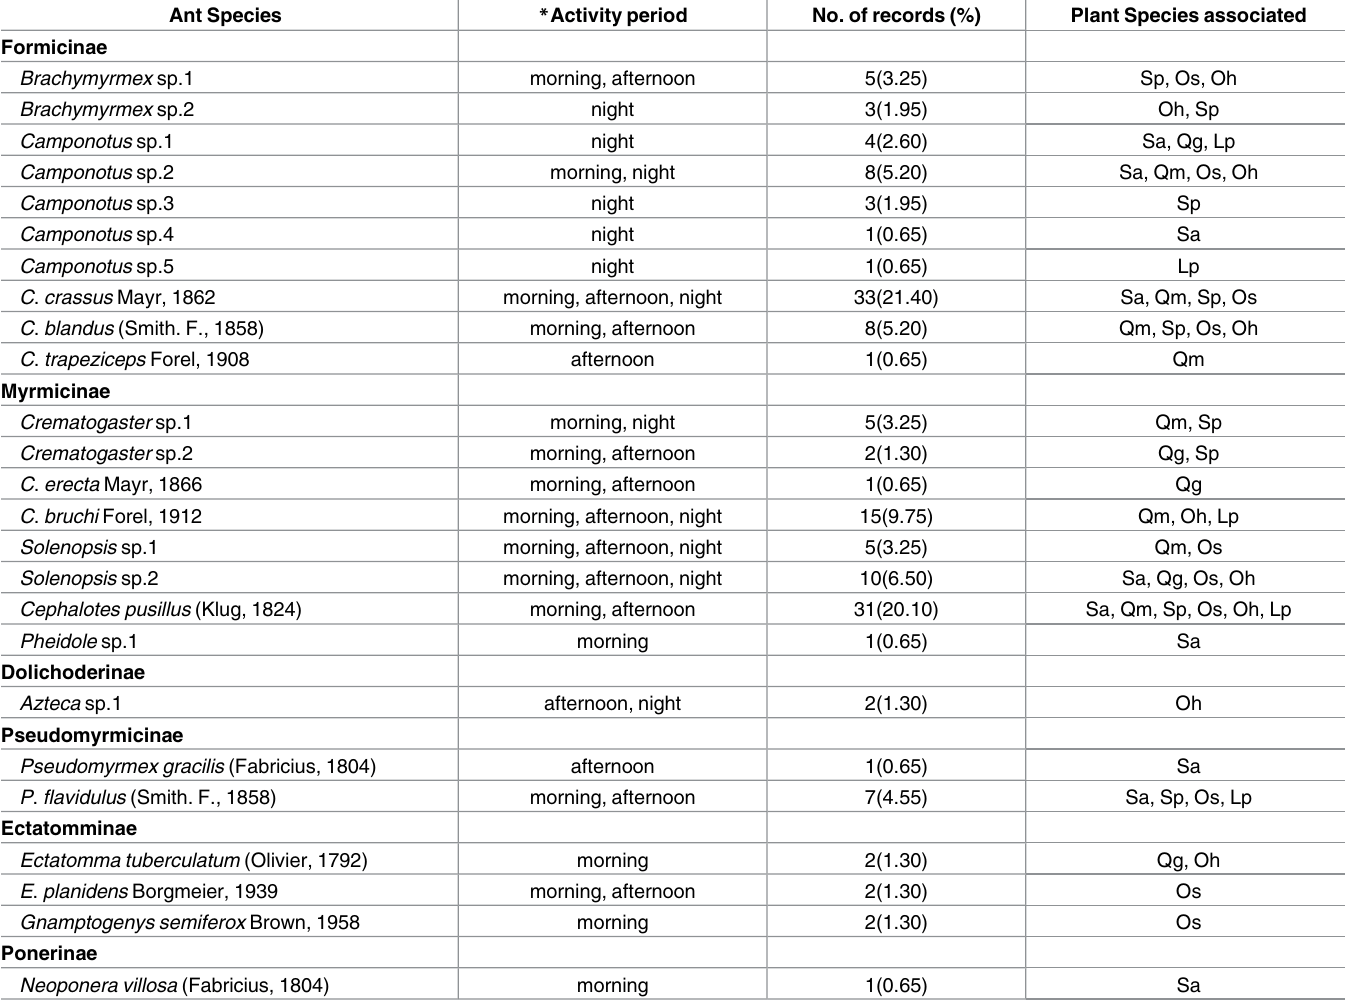
Table 2. Relative frequency (%) and number of records of ant species found in the group of plants (seven species)assessedat three distinct times of the day. Ant Species * Activity